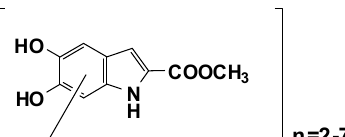
Figure 2. Structure proposed for the methyl ester of 5,6-dihydroxyindole-2-carboxylic acid (MeDHICA)-melanin based on MALDI-MS analysis [42].